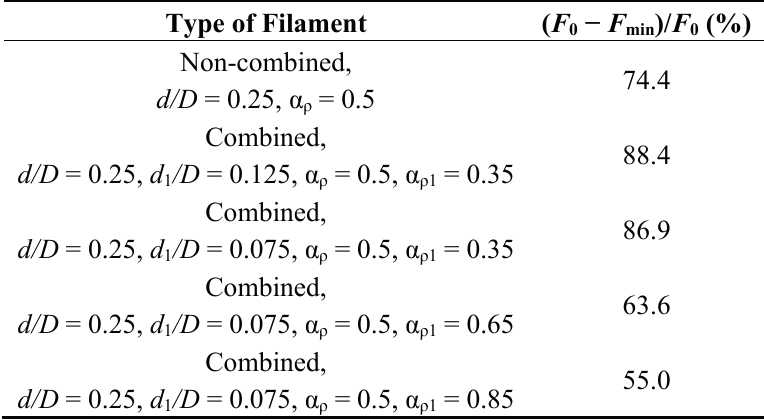
Table 2. Blunt cylinder, M =